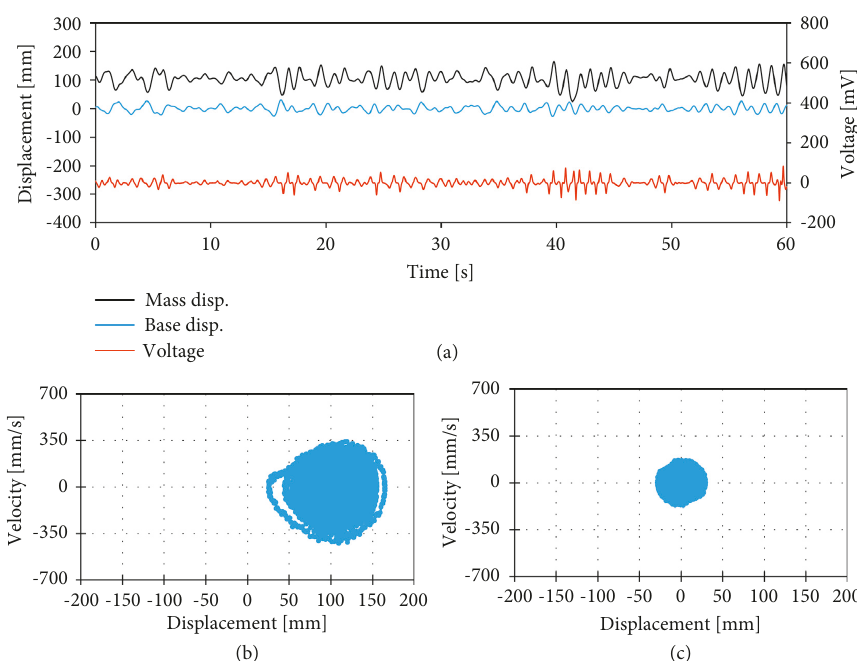
Figure 11: Measured results for vibration displacement and vibration power generation for vibration with a random signal and a periodic signal at 1.00 Hz. (a) Response vibration displacement results. (b) Diagram of displacement vs. velocity of vibration for the mass block. (c) Diagram of displacement vs. velocity of vibration for the support.